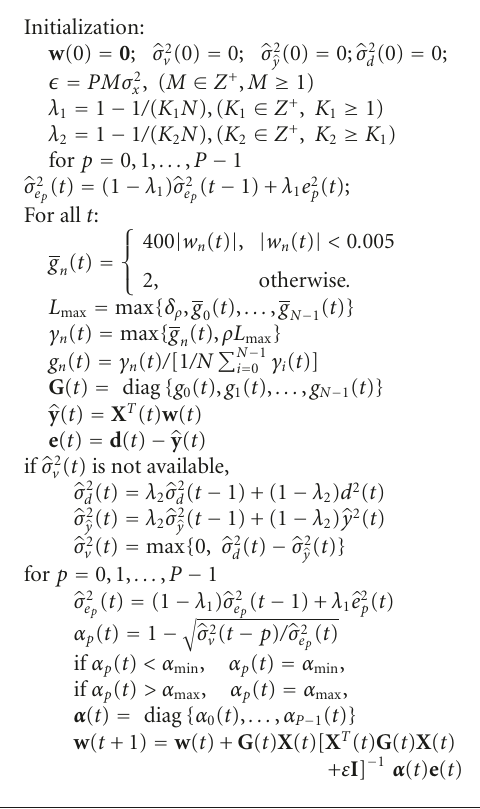
Algorithm 1: The proposed